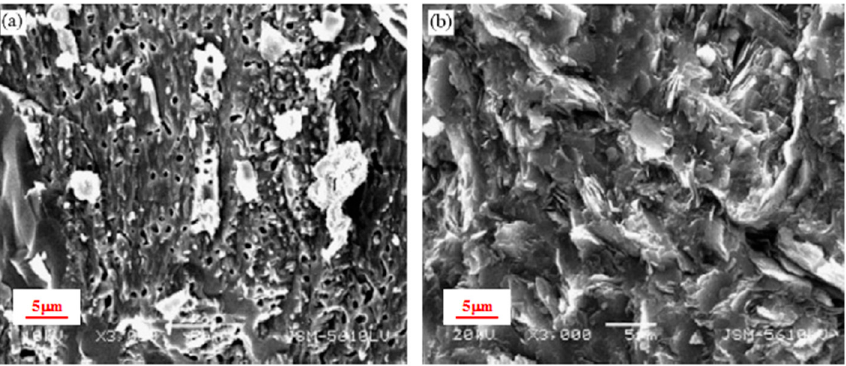
Figure 2. SEM images of BOF slag ( a ) and basalt ( b ).